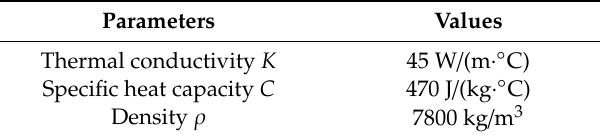
Table 2. Mold attributes (45# steel).